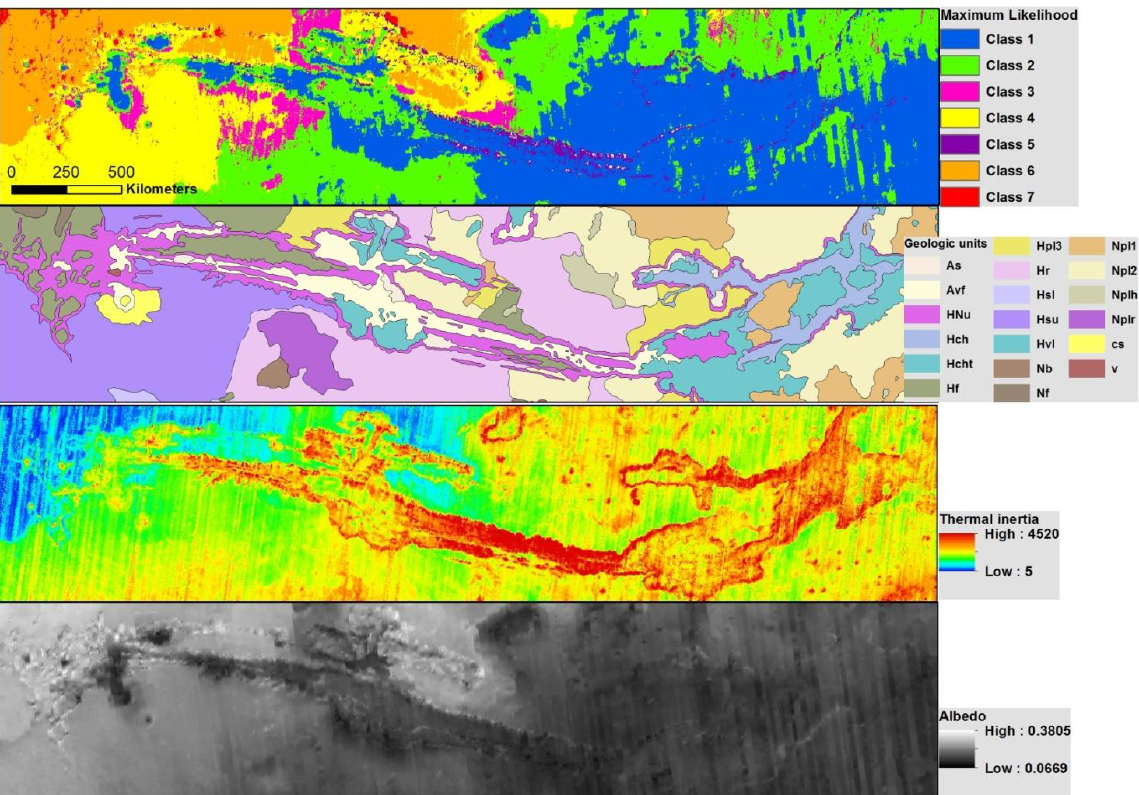
Figure 20. Valles Marineris. A comparison of the canyon system in the thermophysical classification map ( top ; Figure 13); geologic map [156] ( second top ); thermal inertia ( second bottom ); and albedo ( bottom ) datasets used in this work. Although some of